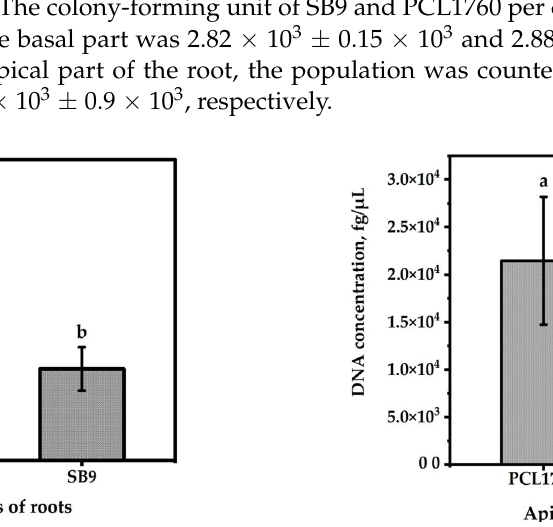
Figure 5. Colonization ability of P. putida SB9 compared with PCL1760. Data are represented as mean ± SD. The significant difference between bacterial strains was evaluated using one-way ANOVA and post hoc Tukey’s honestly significant difference test at a p -value ≤ 0.01. Significant difference among groups is labeled with different letters (a and b).